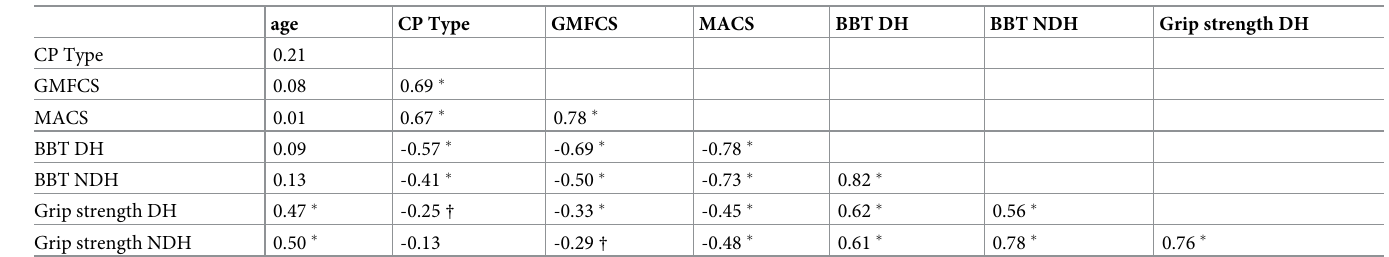
Table 2. Results of the correlation analysis between independent variables.